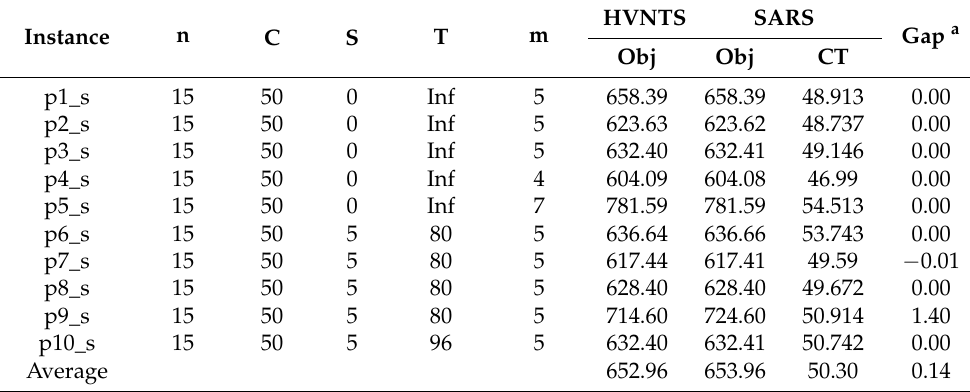
Table 3. Comparison between SARS and HVNTS on small PCP instances. Instance n